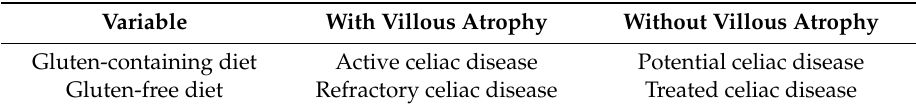
Table 1. Variables in the celiac